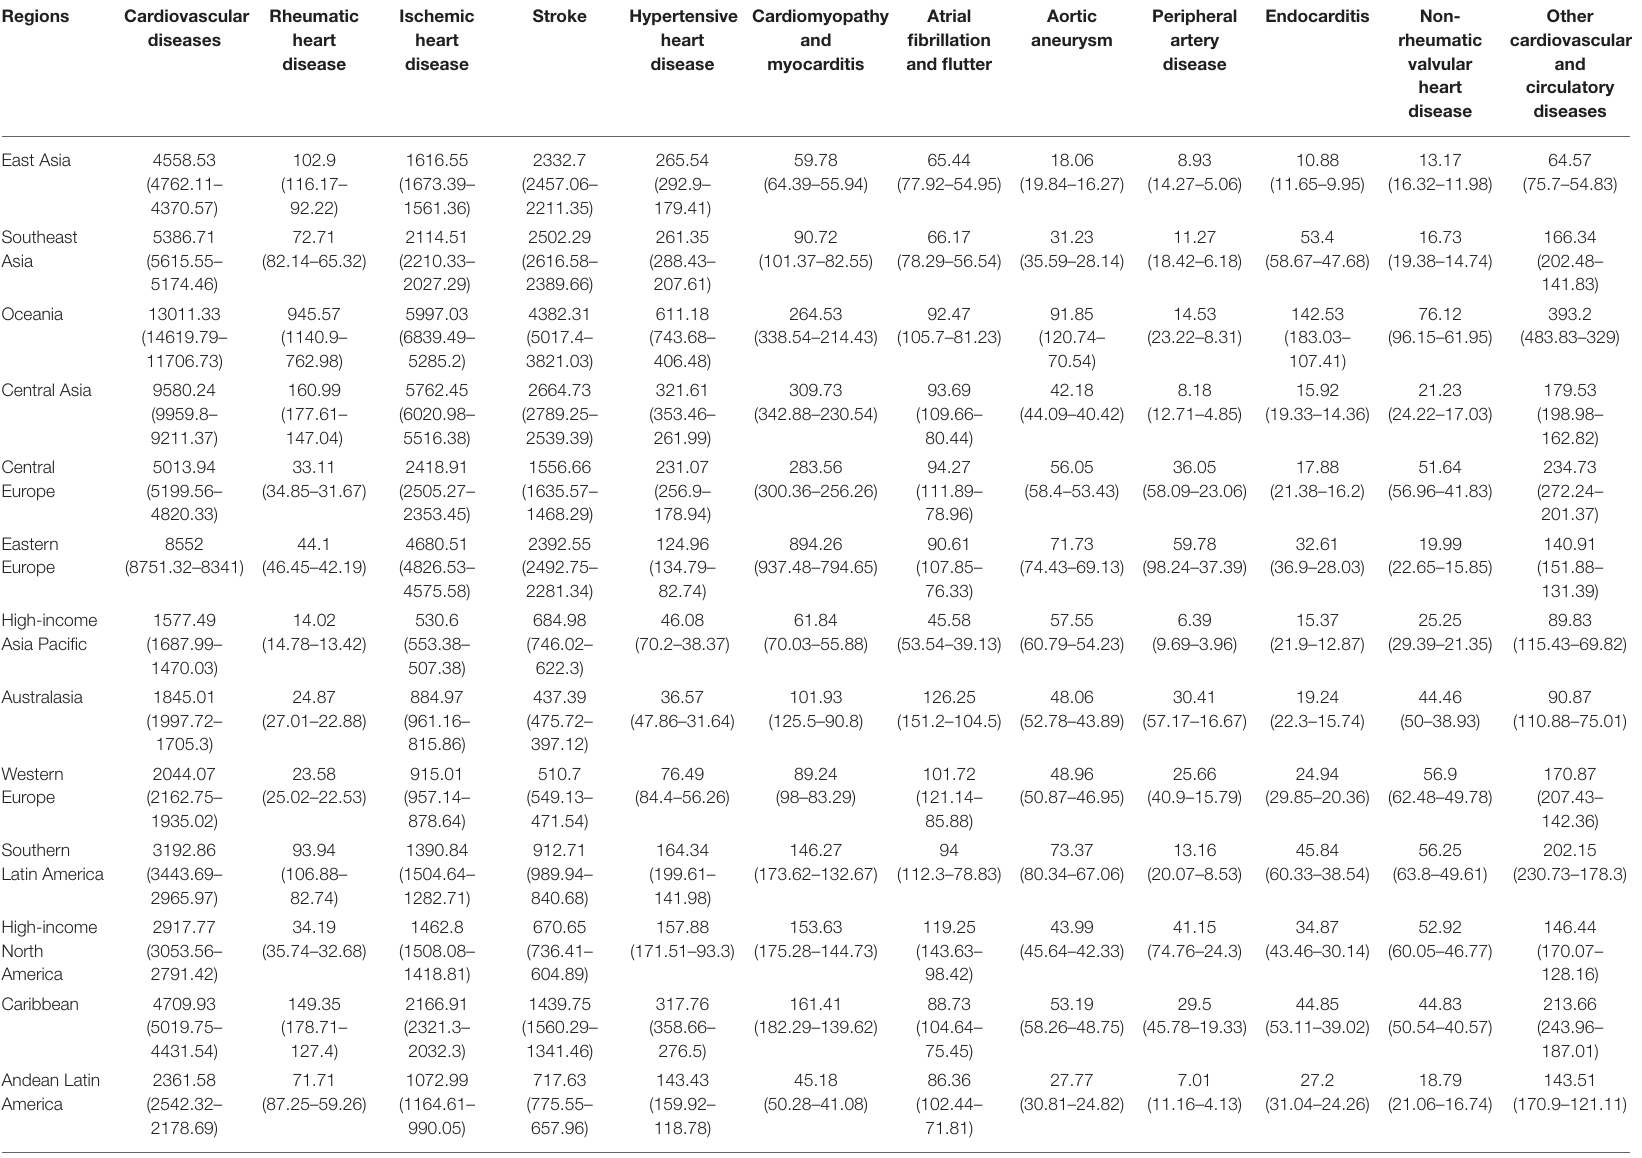
TABLE 3 | The age standardized of DALYs of CVD and its 11 categories for different regions in 2017.